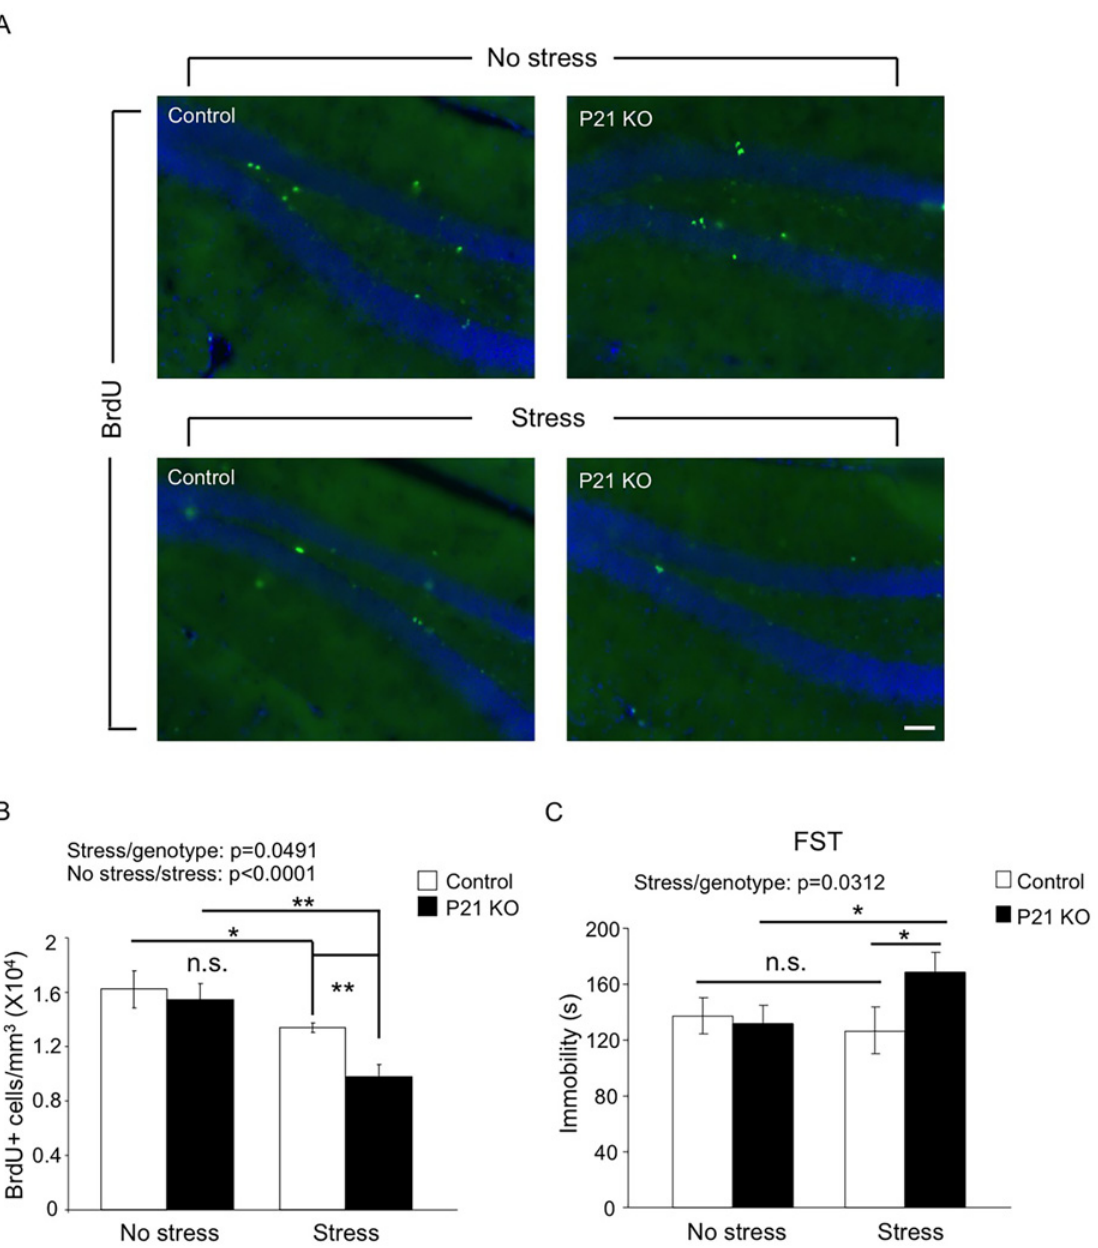
Fig 4. Adult Hap1 expression reduces the stress-induced defective neurogenesis in the hippocampus and depressive-like behavior. ( A ) One-year- old Hap1 P21 KO and control mice were subjected to 4 h restraint stress for 7 consecutive days. BrdU was i.p. injected in the final 3 days of the treatment. Immunostaining of BrdU in the DG was performed 1 day after the final treatment. Scale bar: 50 μ m. The stressed groups showed fewer BrdU+ cells than non- stressed groups, and the decrease was more dramatic for stressed KO mice than stressed controls. ( B ) Stereological quantification of BrdU+ cells in (A). n = 3 – 4 mice per group. ( C ) The forced swim test was conducted 1 day after the final treatment. n = 9 – 11 per group. While stressed control mice did not exhibit depressive-like behavior compared to non-stressed controls, loss of Hap1 caused stressed KO mice to display significant depressive-like behavior compared with stressed control and non-stressed KO mice. All error bars represent SEM. * p < 0.05, ** p <